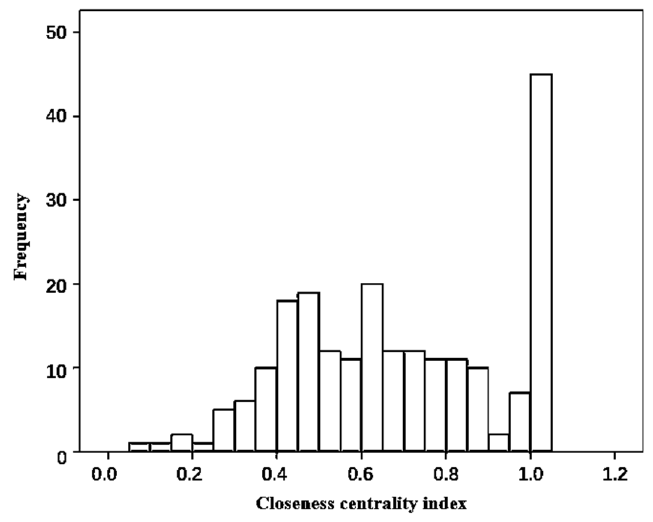
Figure 6. Frequency distribution of the closeness centrality index.